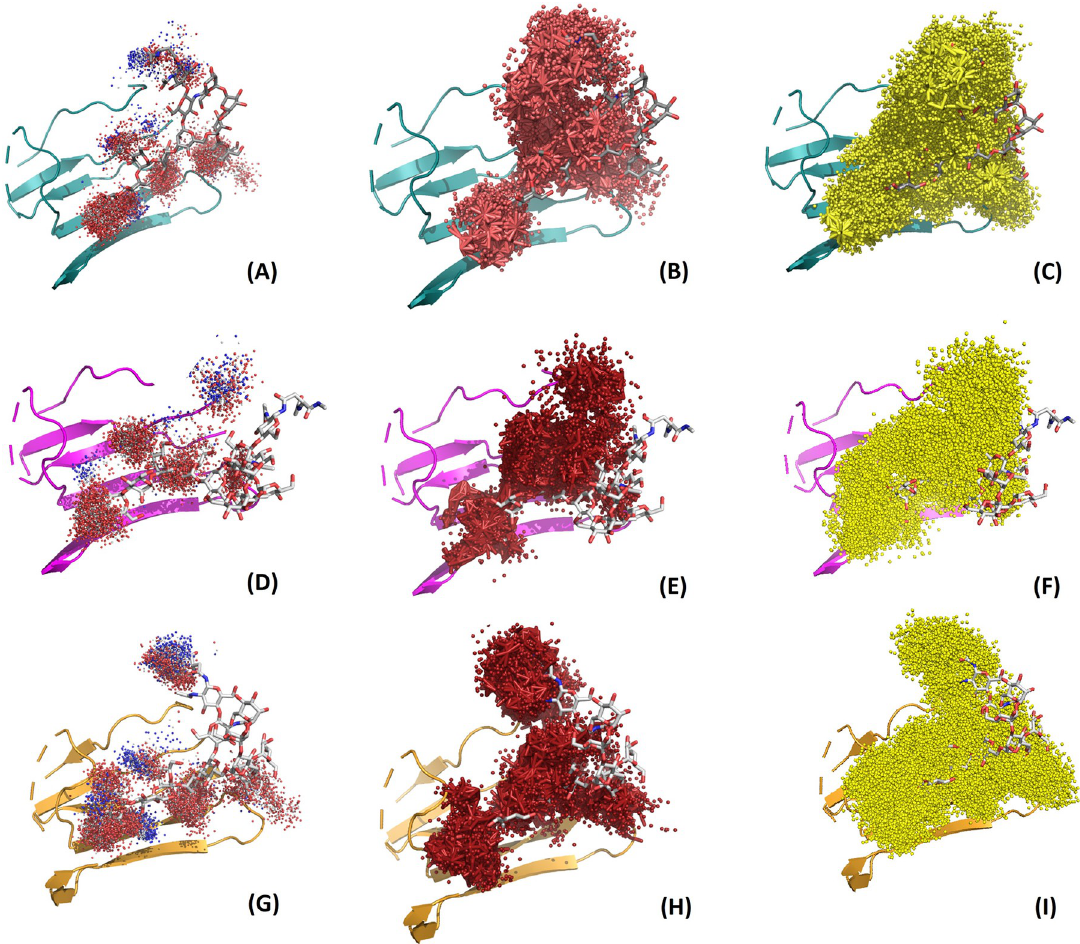
Fig 5. Molecular interaction fields of CNXH upon binding to monoglucosylated-N-glycan computed for the three metastable clusters: (i) Complex_Clus1 (A) Hydrogen bonding interactions; (B) Hydrophobic interactions and (C) van der Waals interactions; (ii) Complex_Clus2 (A) Hydrogen bonding interactions; (B) Hydrophobic interactions and (C) van der Waals interactions; and (iii) Complex_Clus3 (A) Hydrogen bonding interactions; (b) Hydrophobic interactions and (C) van der Waals interactions.